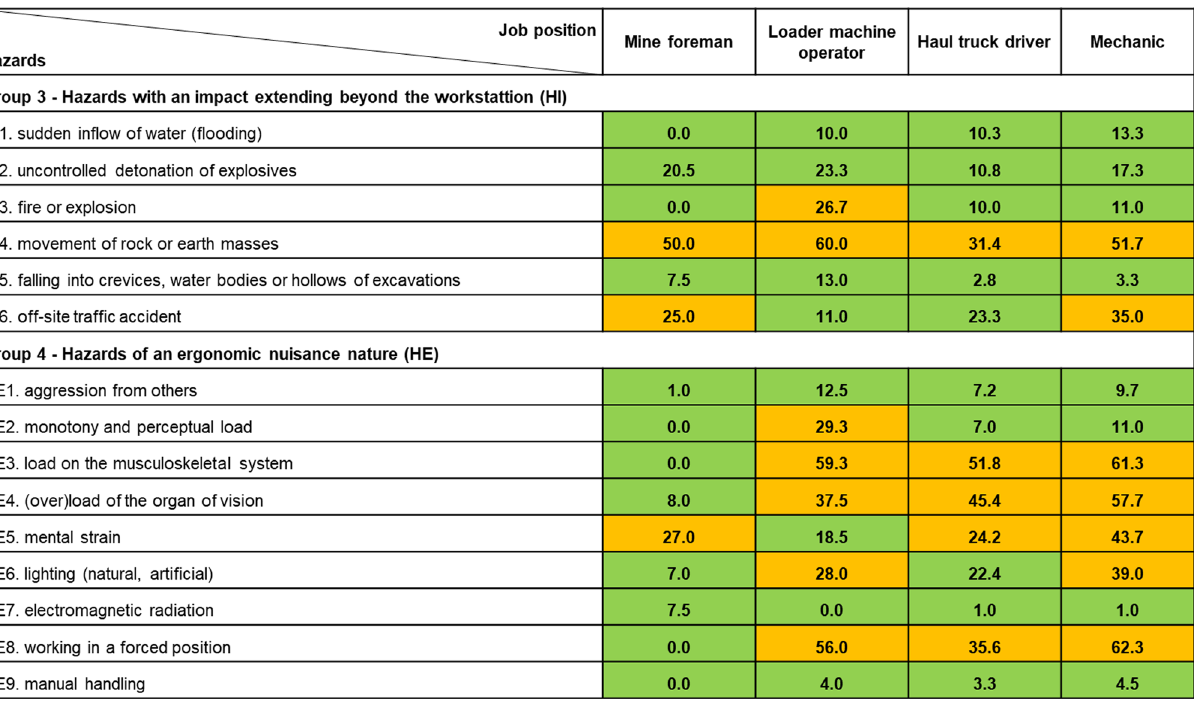
Fig. 5 The results of occupational risk assessment for the analyzed positions—hazards from groups 3 and